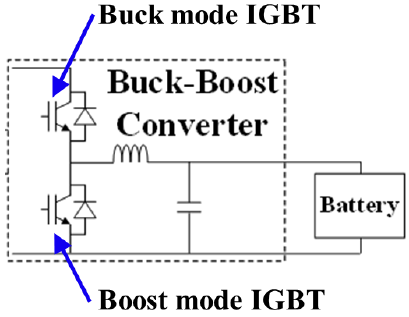
Figure 8. Equivalent Circuit of BESS (Battery Energy Storage System) Composed of Bidirectional Buck-Boost Converter and